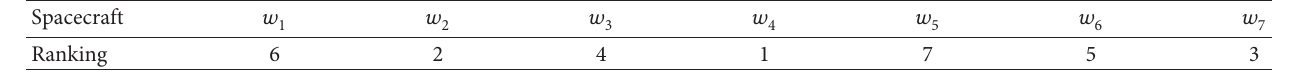
Table 22: Hierarchical ranking of spacecraft.